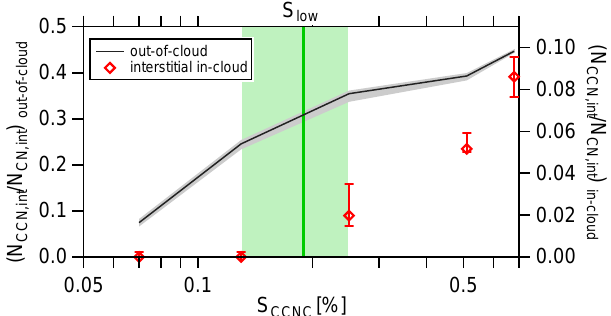
Figure 3. Integral CCN efficiency measured for total aerosol during out-of-cloud conditions (grey shaded area, range of measured data points ± statistical error) and for interstitial aerosol in one example measurement during in-cloud conditions (red data points; error bars correspond to the individual statistical errors) plotted as a function of S CCNC . The measurement times are the same as in Fig. 2. The vertical green line and shaded area represent the arithmetic mean and standard deviation range of S low (CCNC). Since the activated fraction is much lower for in-cloud conditions, N CCN,int is illus- trated on the right axis with a smaller